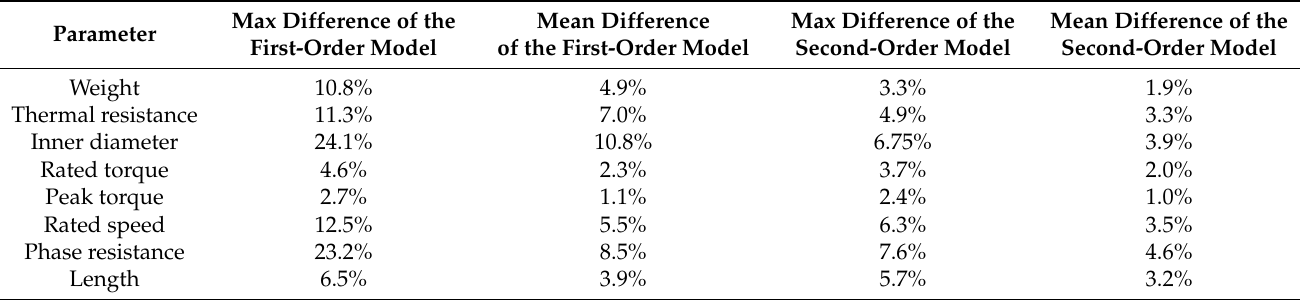
Table 3. The difference between the estimated results of motor parameters and the